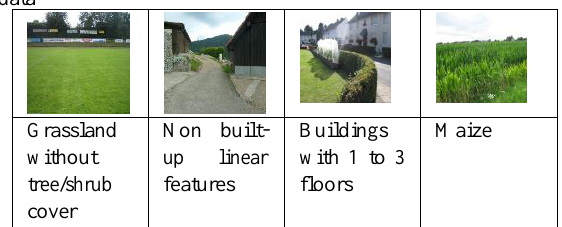
Grassland without tree/shrub